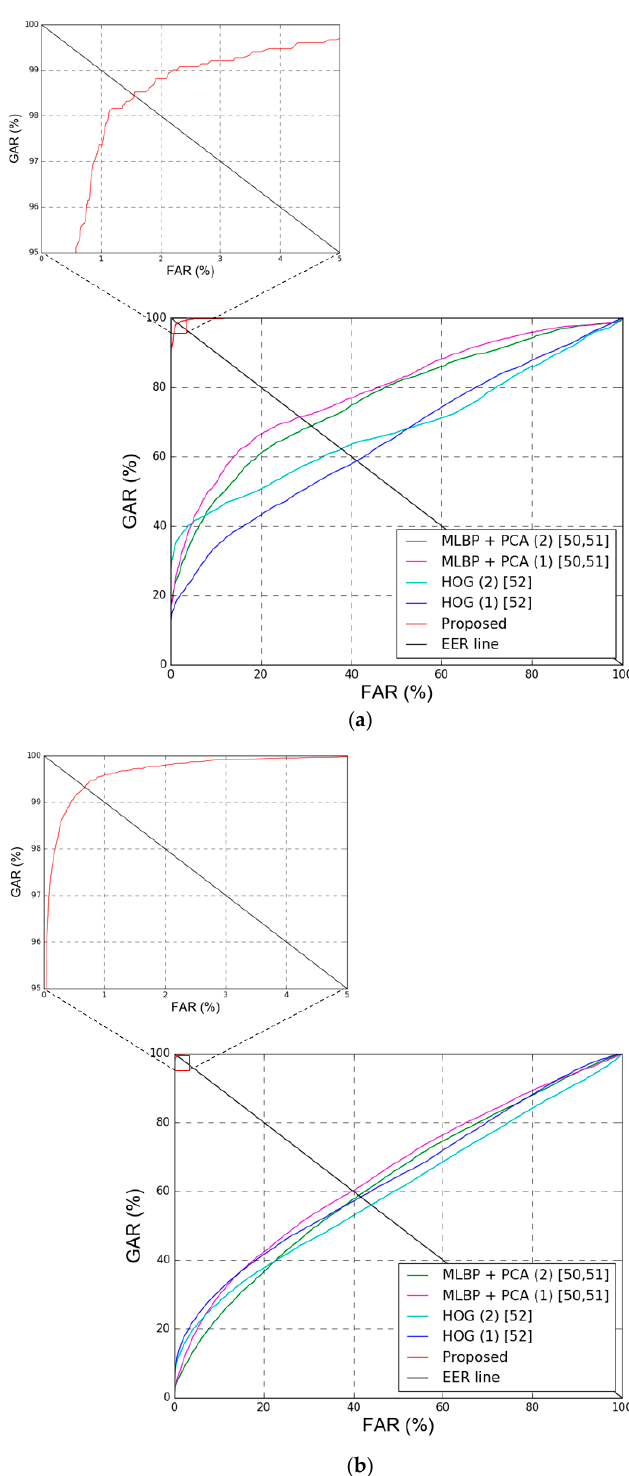
Figure 16. ROC curves by proposed and previous methods. With ( a ) Dongguk face and body database (DFB-DB1) and ( b ) ChokePoint datasets. In ( a , b ), multi-level local binary pattern (MLBP) + principal component analysis (PCA) (1) and MLBP + PCA (2) mean the methods of MLBP + PCA based on geometric center by feature difference and pixel difference of Table 12, respectively. In addition, histogram of oriented gradient (HOG) (1) and HOG (2) mean the methods of HOG based on geometric center by feature difference and pixel difference of Table 12, respectively. GAR, FAR, and EER mean genuine acceptance rate, false acceptance rate, and equal error rate,